Question: What does this figure show? Answer in one sentence.
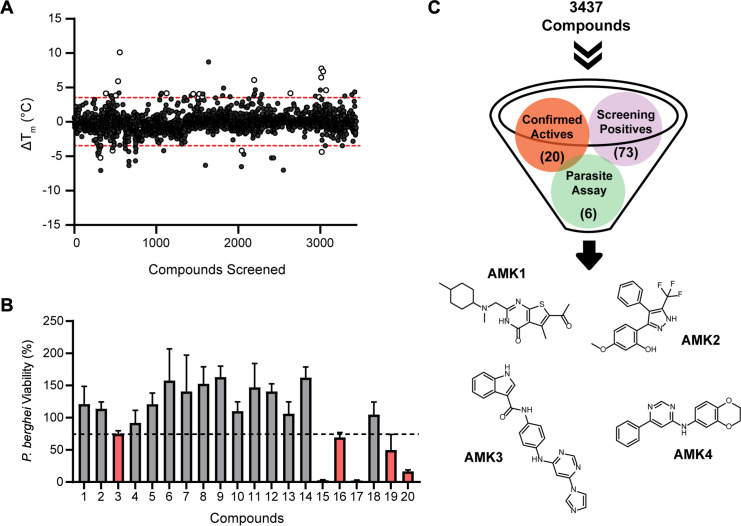
Answer: High-throughput screen identifies molecules that bind to Pf Hsp70-1. ( A ) Change in melting temperature (Tm) of Pf Hsp70-1 with the addition of 3,437 compounds relative to DMSO. Threshold for actives was a Tm change of ≥3.5°C (red dashed line). Actives were confirmed through a 5-point dose-response curve (open circles). ( B ) Confirmed actives (compounds 1–20 at 10 µM) were tested for inhibition of P. berghei liver stage parasites, identifying six compounds (red bars) that reduced parasite load (black dashed line denotes 25% inhibition). Data shown as the average ± SEM ( n = 3). ( C ) Summary of the TSA screening strategy that identified four hits (AMK1–4).